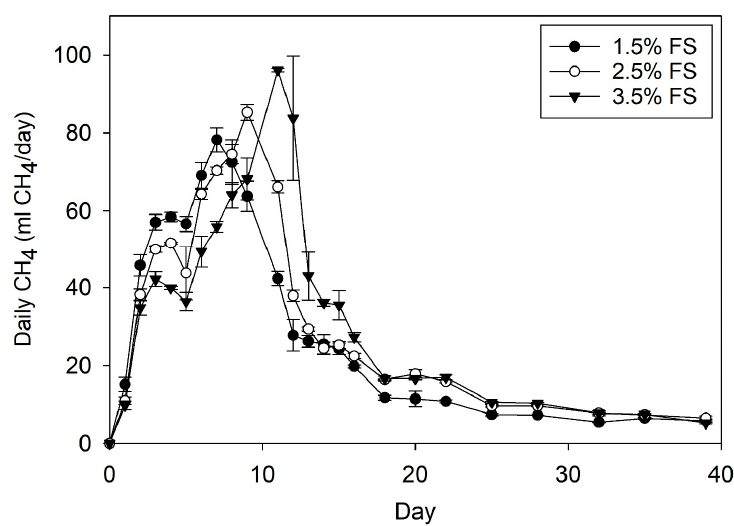
Figure 1. Daily methane production rate using fish sludge as the anaerobic digestion substrate at three different initial solid concentrations.